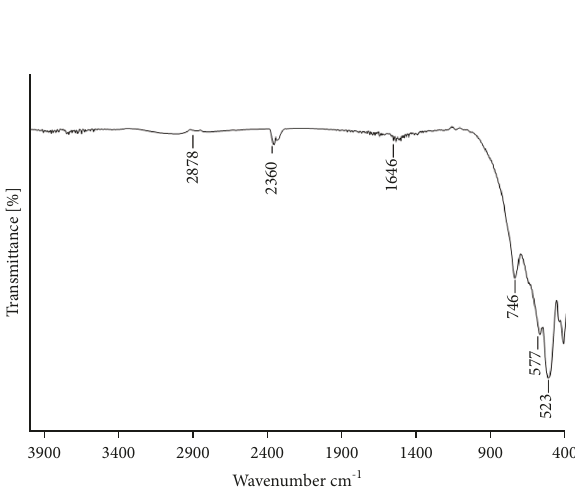
Figure 2: FTIR spectra of ZrO the